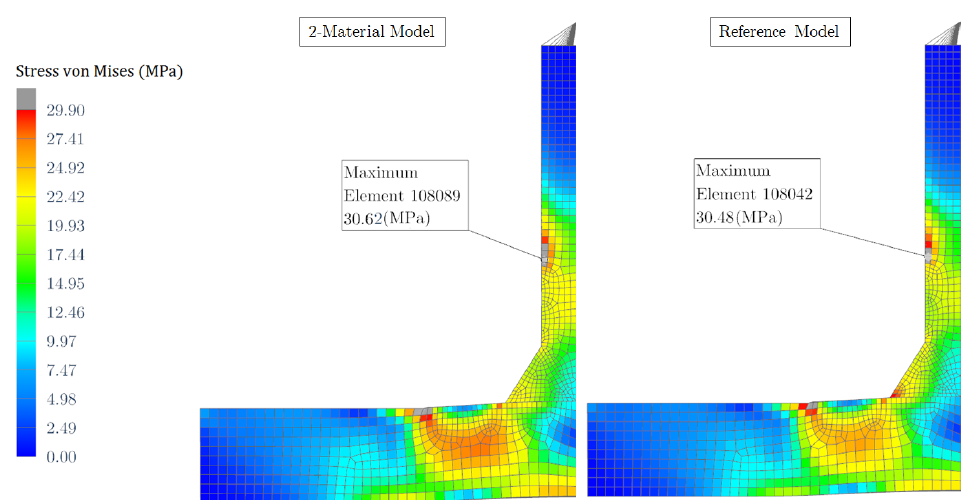
Figure 5. FE stress results of the 2-Material (left) and the reference model (right).